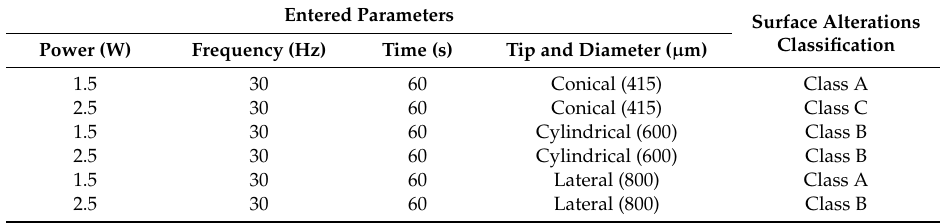
Table 2. Main outcomes of the study. W: Watts; Hz: Hertz; sec: seconds; µ m: micrometers; cm: centimeters; r: radius; d: diameter; A: Area; P d : Power density; J: Joules; E p : Pulse energy; P m : Mean